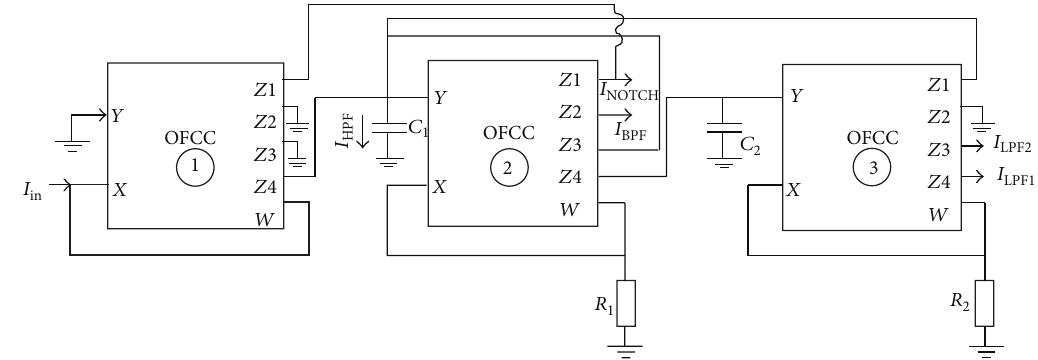
Figure 3: Proposed OFCC based single-input four-output current mode